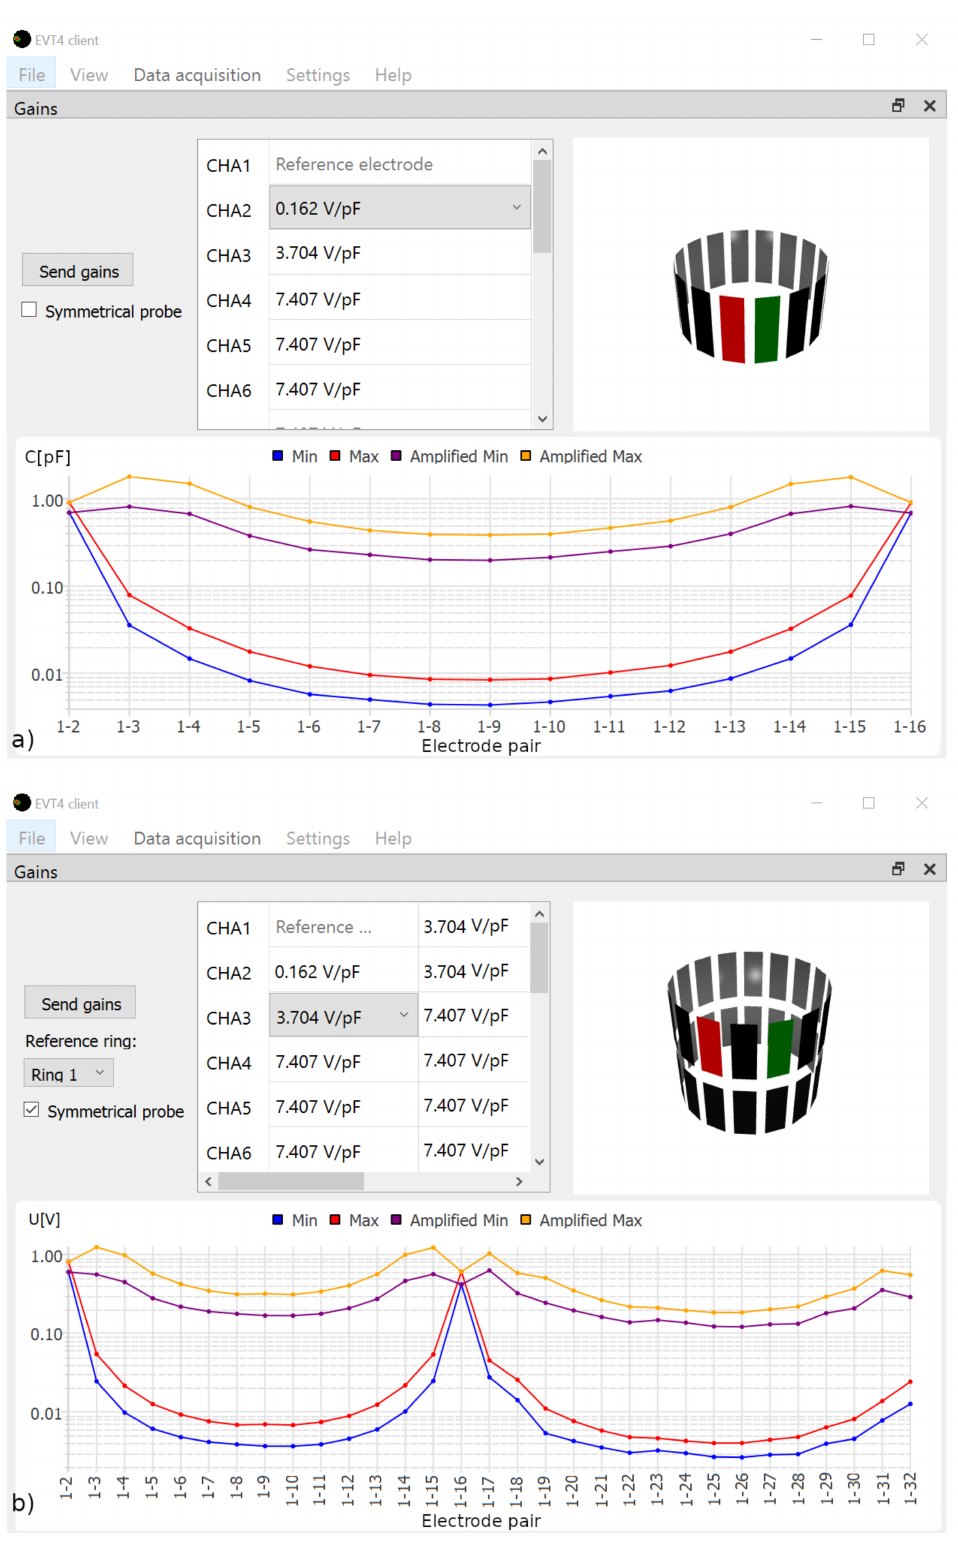
Figure 11. EVT4 client graphical user interface for gain adjustment for: ( a ) 2D sensor; ( b ) 3D sensor. The stimulating electrode is marked in red on the sensor model. The green electrode is the sensing electrode for which the gain is being set. The estimated signal value at low gain for the sensor filled with low (Min) and high (Max) permittivity material. The estimated value at high gain (Amplified Min, Amplified Max). The high gain is set for all electrode pairs except the adjacent